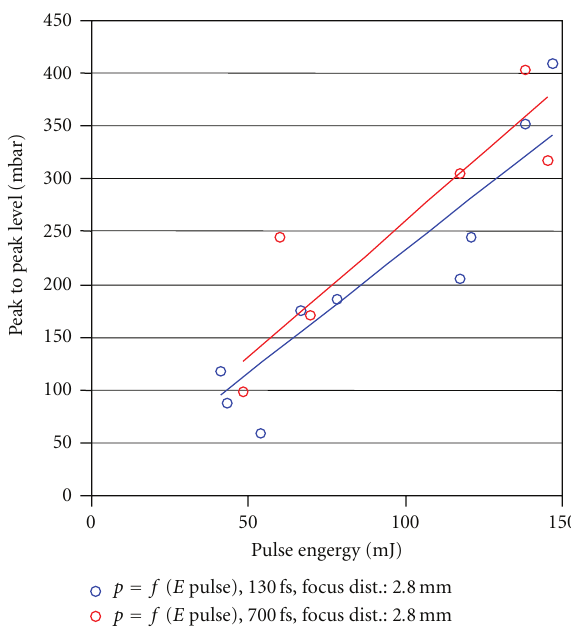
Figure 10: Peak pressure in relation to pulse energy using the fs laser, at varying fs pulse